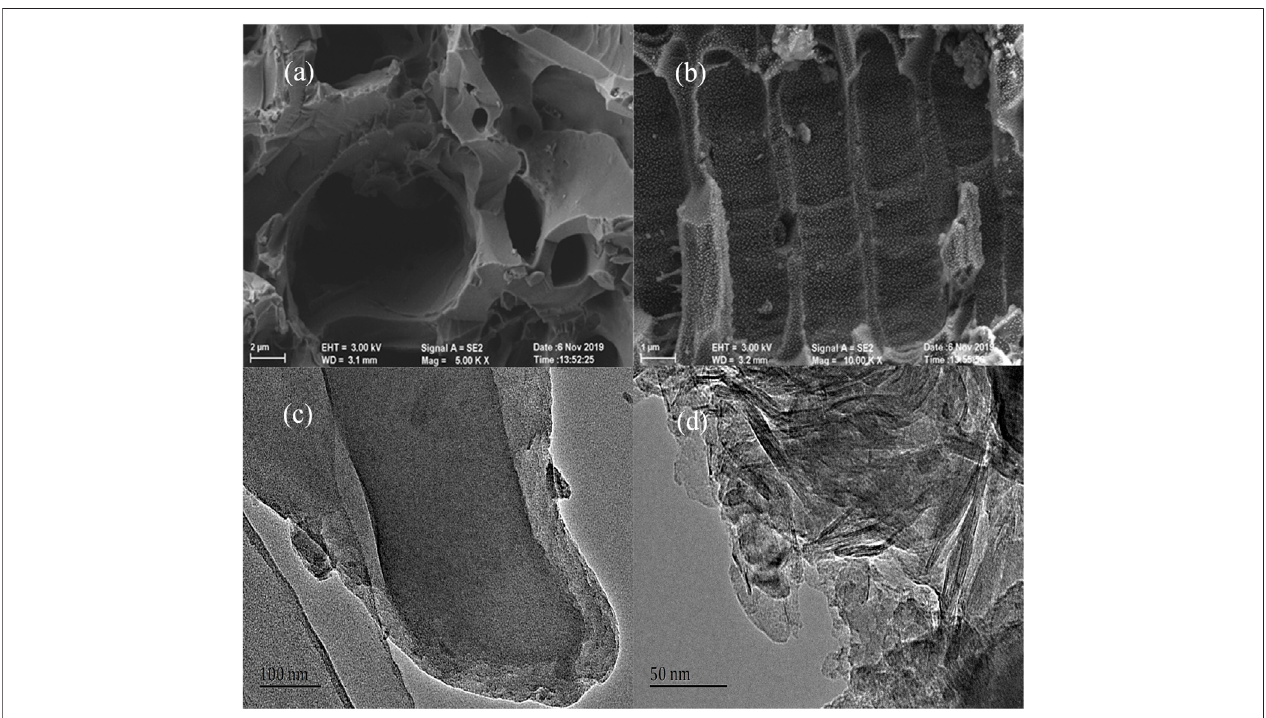
Zeta potentials of MMT/BC are depicted in Supplementary Figure S3 . In the pH range between 2 and 9, the MMT/BC resulted in a zeta potential drop of 35 mV. The MMT/BC surface was negatively charged at pH values greater than the point of zero charge pH (pH pzc , 2.7) and was positively charged at pH values lower than pH pzc (Nandi et al., 2009).